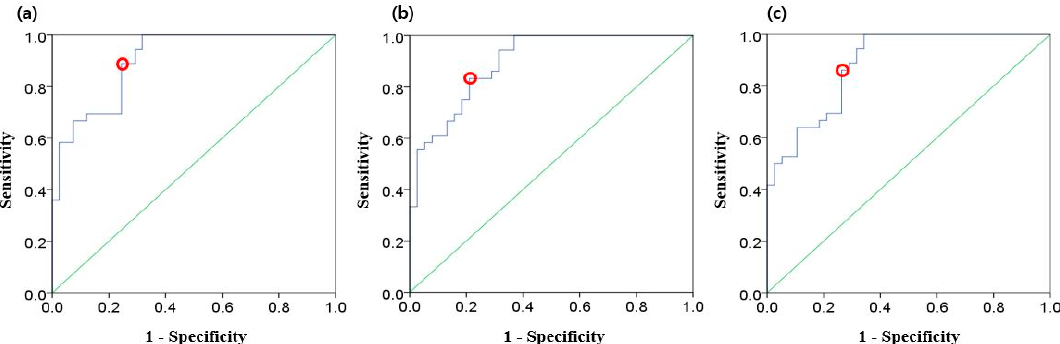
Figure 6. Receiver operating characteristic (ROC) curves (blue) for three EEG parameters: ( a ) magnitude; ( b ) log energy entropy; ( c ) Rényi entropy . Red dots indicate the optimal cut ‐ off points, and the diagonal lines (green) indicate random chance. Table 4. Results of the ROC curve analysis for EEG parameters.